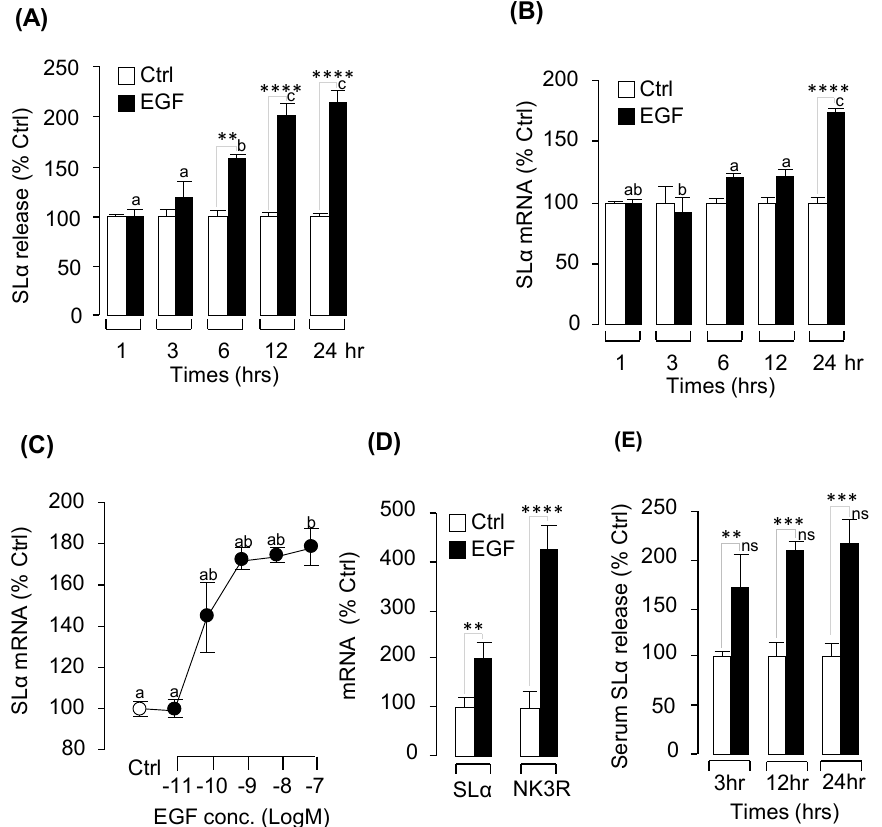
Figure 2. EGF-induced grass carp somatolactin α (SL α ) secretion and mRNA expression in vitro and in vivo. Time course of human EGF (100 nM) treatment on SL α secretion ( A ) and mRNA expression ( B ) in grass carp pituitary cells. ( C ) Dose-dependence of 24-h treatment with increasing levels of EGF (0.01–100 nM) on SL α secretion and mRNA expression in grass carp pituitary cells (the white circle represent the control group, and the black circles are the EGF-treatment groups). In vivo effects of EGF (2 ng/g body weight) on pituitary SL α mRNA expression ( D ) and serum SL α secretion ( E ) in prepuberty grass carp. In these experiments, one-way ( C , D ) and two-way ( A , B , E ) ANOVA were used to test for significant differences in the control group and EGF-treatment group. ** p < 0.01, *** p < 0.001, **** p < 0.0001, “ns” was used to present that there were no significant differences among the EGF-induced SL α secretion at 3 h, 6 h and 24 h. The different lower-case letters were used to reveal the significant differences between the EGF-treatment group and the control group ( p < 0.05).